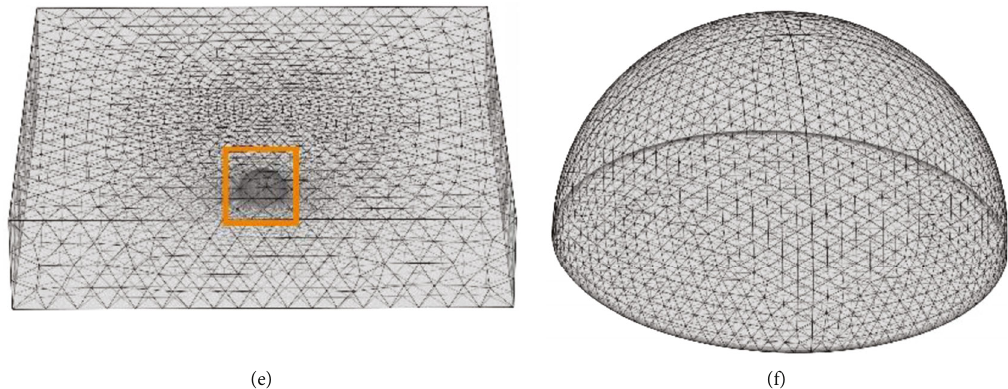
Figure 1: Establishment of gradient parallel plate fl ow chamber and FE model. (a) Photo of custom-made gradient fl ow chamber, in which the arrow represents the direction of FSS gradient. Schematics of gradient fl ow chamber in cross-sectional view (b) and side view (c). (d) FE mesh indicated by the blue box in (a). (e) FE mesh around a cell indicated by the green box in (d). (f) FE mesh of the cell indicated by the yellow box in (e). Table 1: Parameters used in the FEA. Material